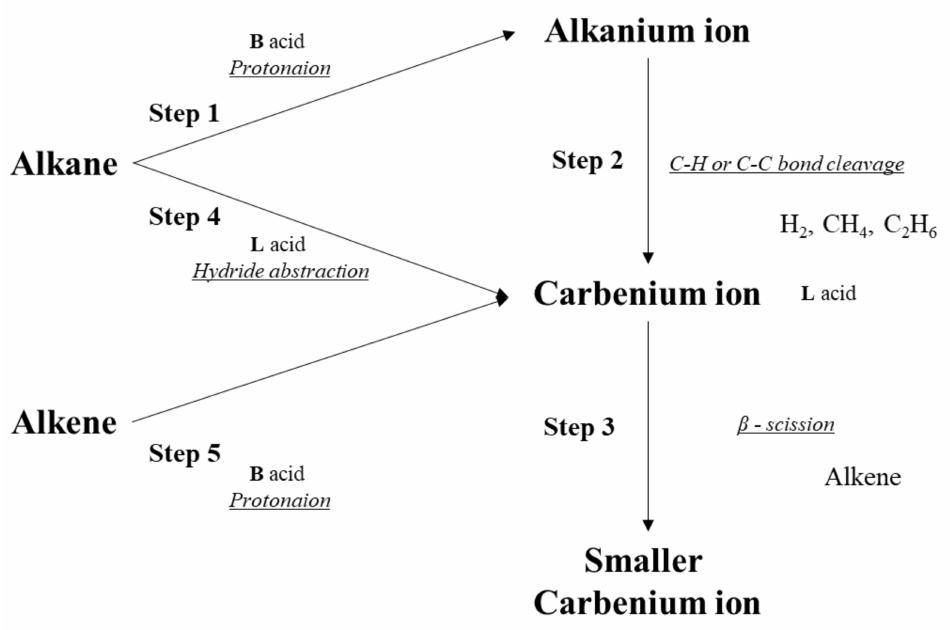
Scheme 1. Cracking reaction mechanism over heterogeneous solid acid